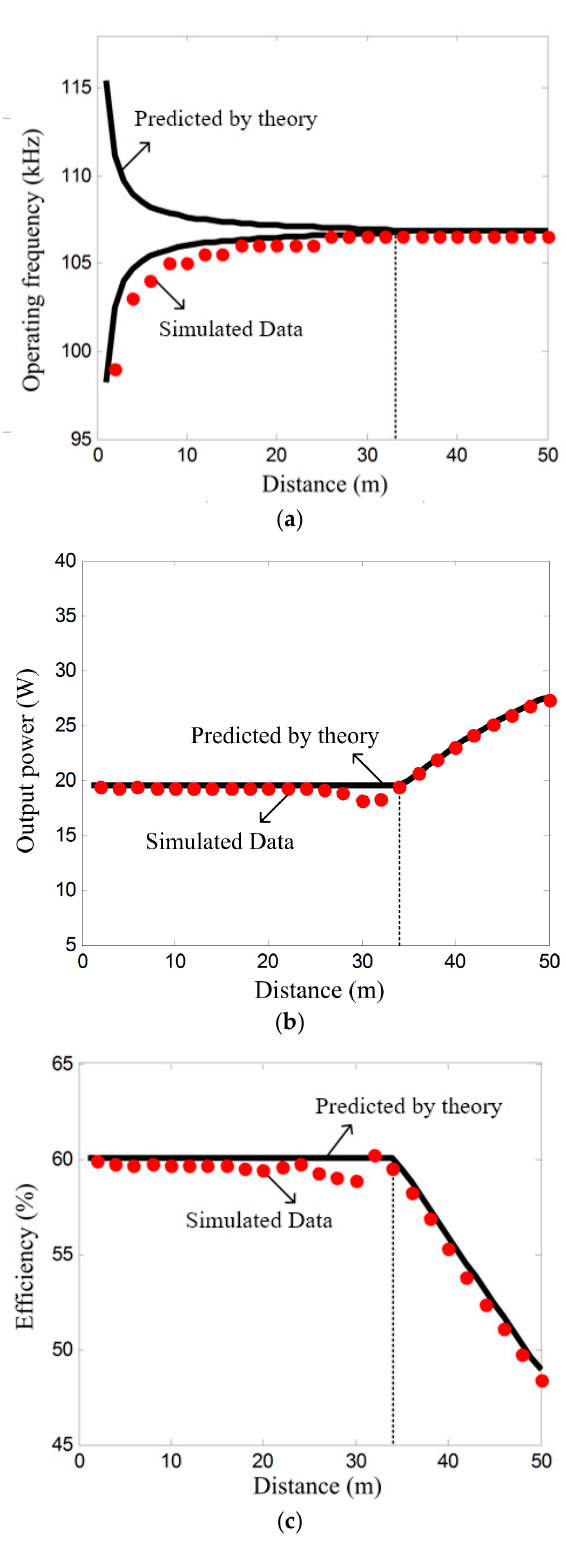
Figure 5. Calculated and simulated values of operating frequency, output power, and transmission efficiency as a function of distance between transmitter and receiver, the black solid line is the theoretical values derived from the equations of system, the red solid point is the simulated values by the circuit simulation: ( a ) operating frequency versus distance; ( b ) output power versus distance; ( c ) efficiency versus distance.